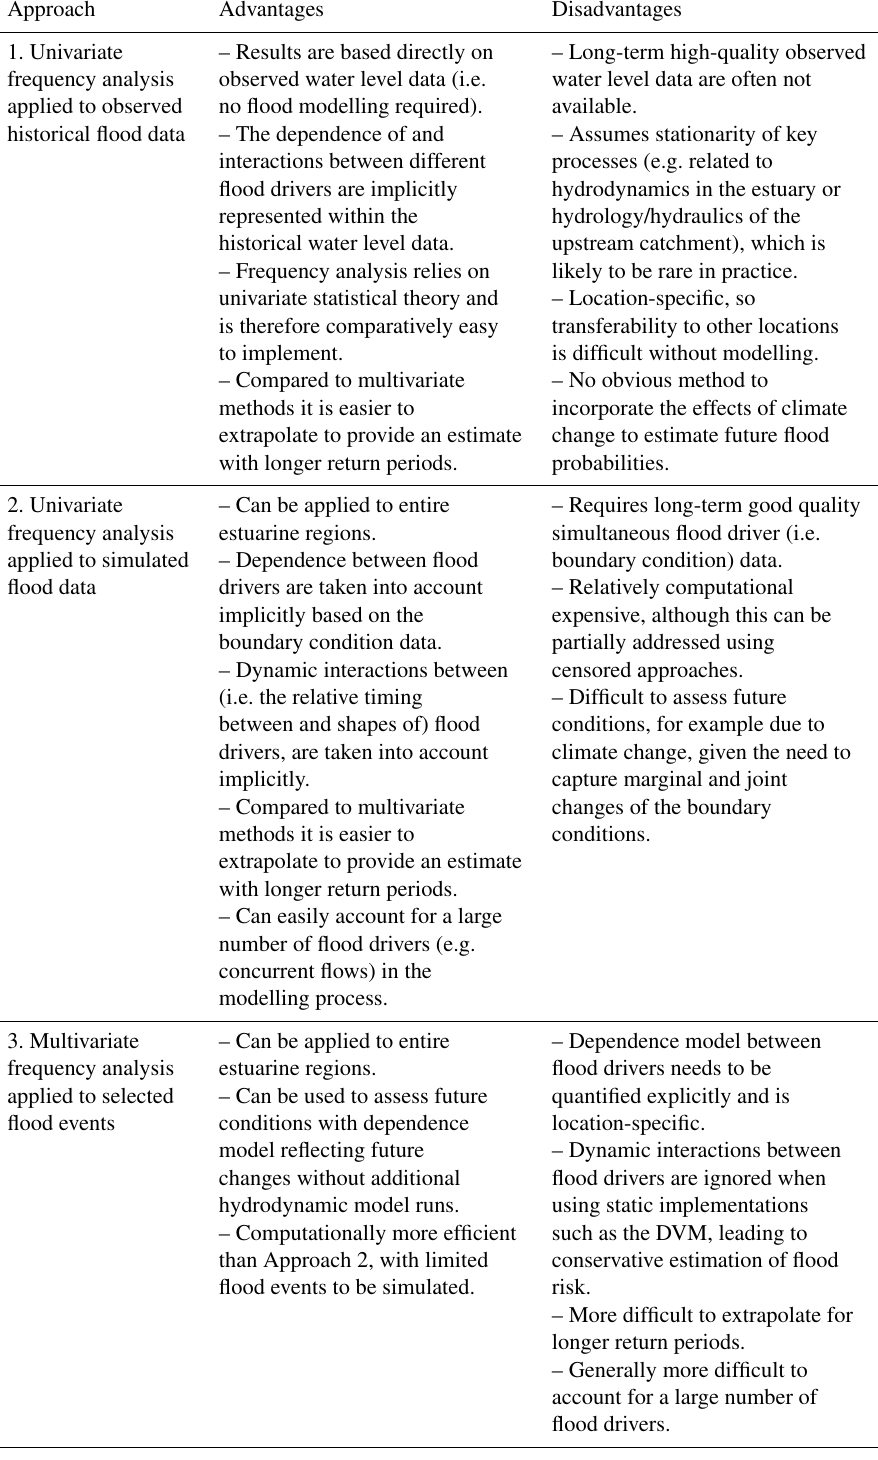
Table 2. Comparative summary of flood estimation approaches for estuarine